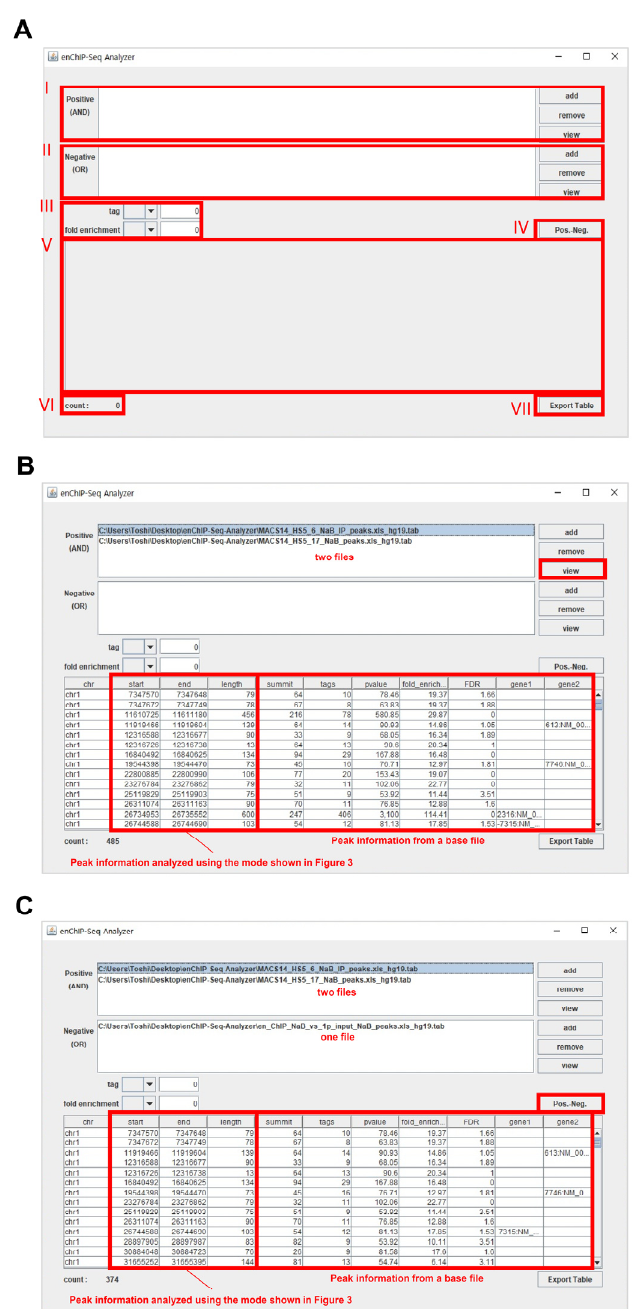
Figure 4. The main screen of enChIP-Seq analyzer. ( A – C ) Examples of the screens of enChIP-Seq analyzer. Handling processes are shown in the main text.